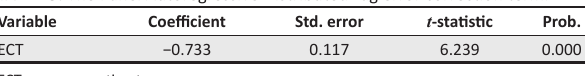
TABLE 5: The Panel Autoregressive Distributed Lag error correction term. Variable